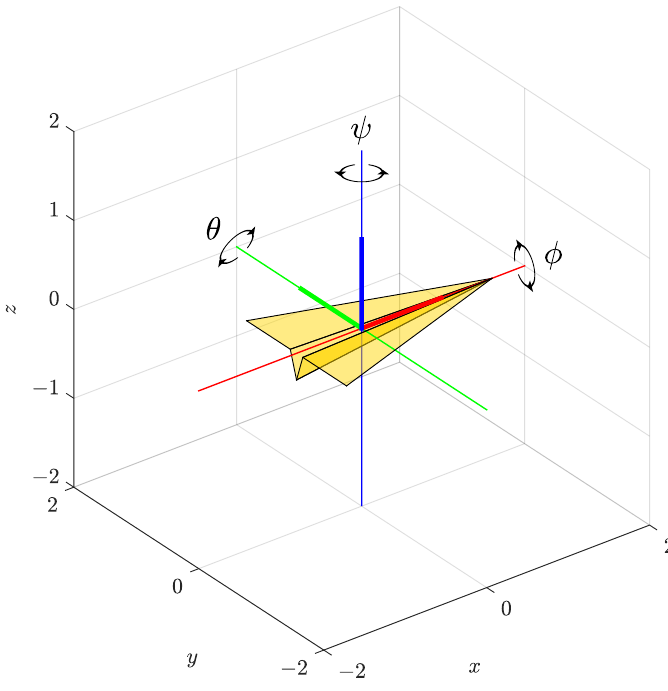
Figure 1. Euler angles ψ , θ , and φ representing the attitude of an object in 3D space. The first rotation is applied around the z -axis of the inertial coordinate system for angle ψ . This rotation defines a new local coordinate system V 1 whose z -axis is aligned with the z -axis of the inertial coordinate system, while the x and y -axis of the coordinate system V 1 are rotated for angle ψ . This rotation is represented by the matrix R v 1